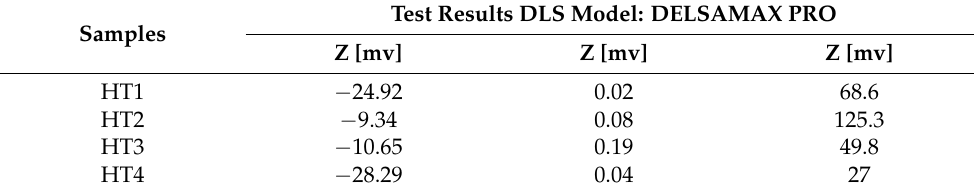
Table 4. DLS values for obtaining samples by solvothermal synthesis coded HT.